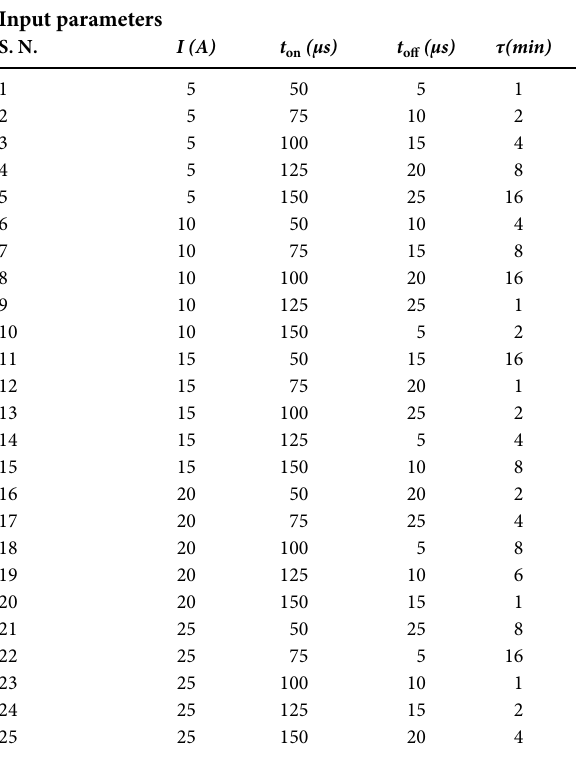
Table 4. The results of experimental design by using L25 orthogonal arrays. Input parameters